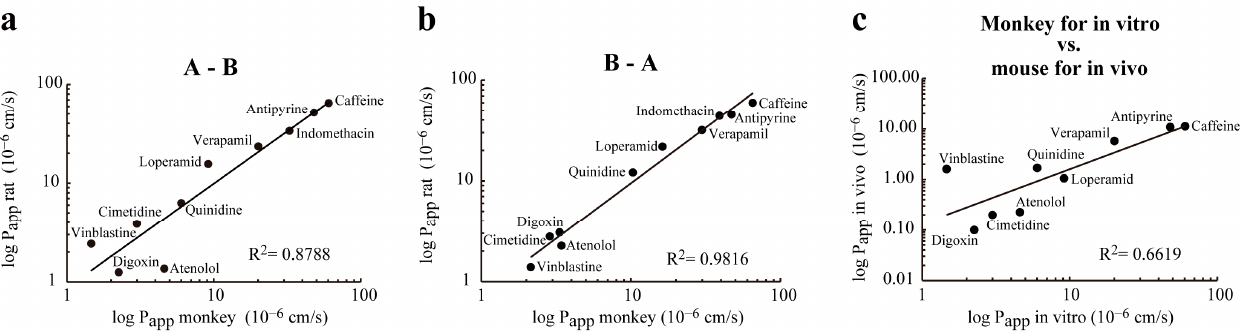
Figure 7. Correlation between permeability (Papp) data of drugs tested in in vitro rat BBB model, in vitro monkey BBB model, and mouse in vivo model. ( a ) Correlation between permeability of drugs in the apical to basolateral (A-B) tested at rat BBB model and monkey BBB model. ( b ) Correlation between permeability of drugs in the basolateral to apical (B-A) tested at rat BBB model and monkey BBB model. ( c ) Correlation between permeability of drugs tested at monkey BBB model (Papp in vitro) and the permeability of the same drugs measured in animal models (Papp in vivo).